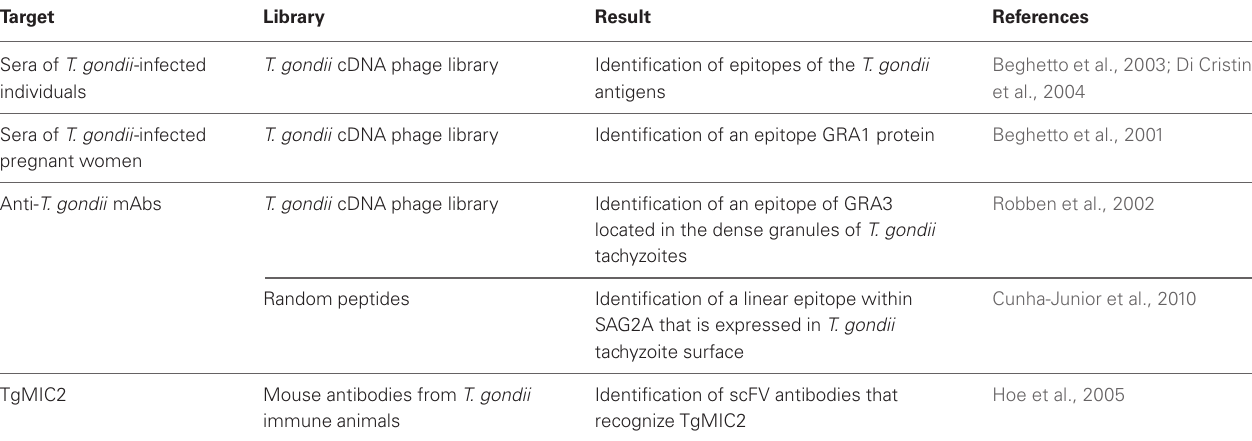
Table 2 | Summary of phage display applications in T. gondii research.